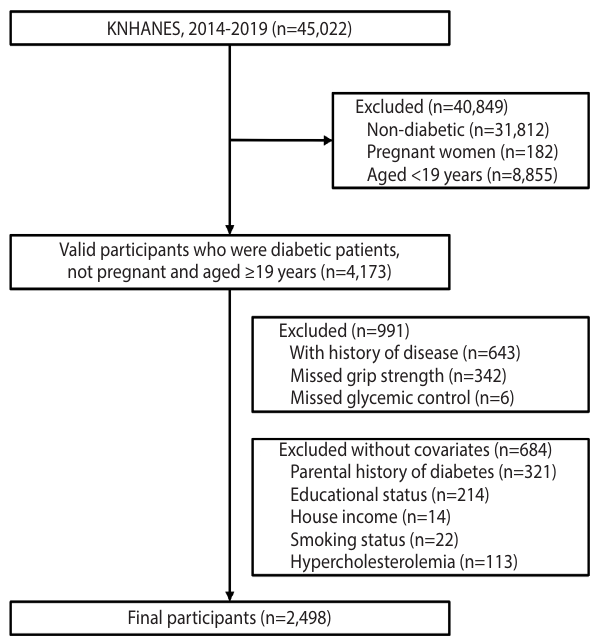
Figure 1. Flow diagram of participants excluded. KNHANES, Korea National Health and Nutrition Examination